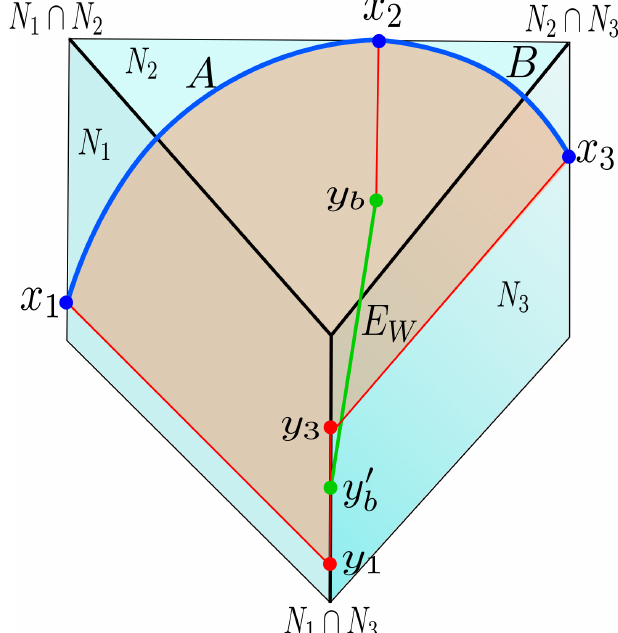
Figure 5: Schematics of the holographic construction for computing the extremal EWCS for two adjacent intervals in a GCF T ically flat